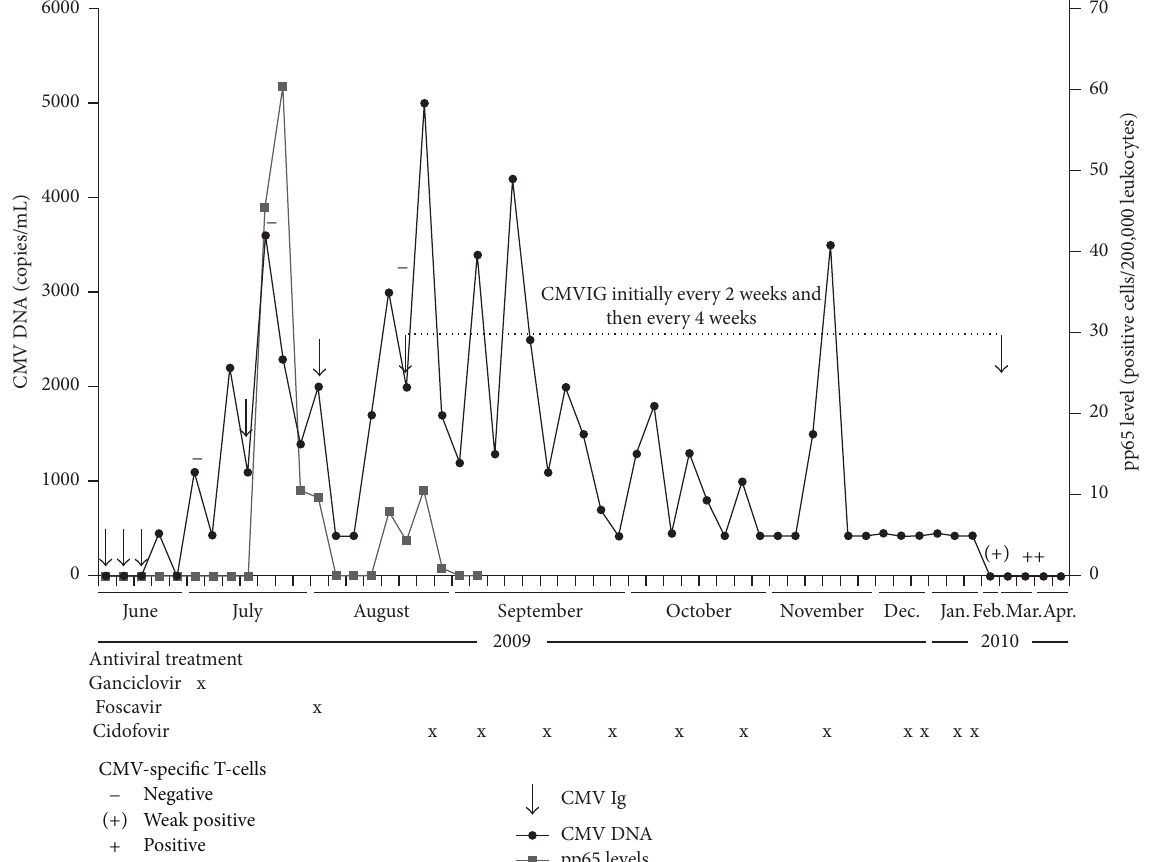
Figure 1: Schematic of CMV treatment, CMV-DNA, and pp65 levels over time. The absence and presence of CMV-specific CD4 + T-cells as determined by flow cytometry are indicated by ( − ) and (+) symbols. CMV-DNA was quantified from whole blood using the Cobas-Amplicor- assay (Roche Diagnostics) with a clinically relevant detection limit of 450 copies/mL. A cut-off of CMV-specific CD4 + T-cells of ≥ 0.05% was considered